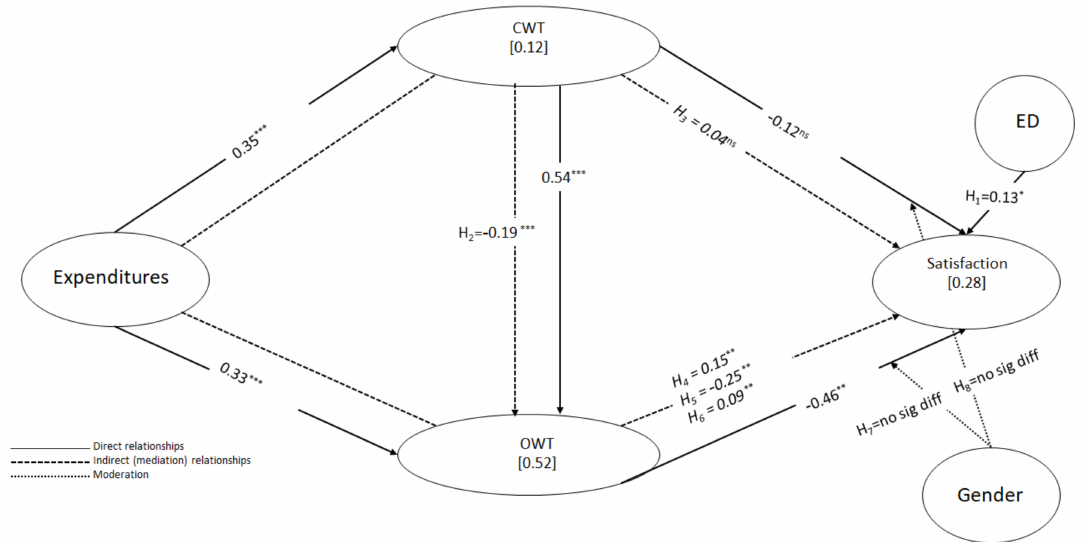
Figure 2. Whole model results. *: p < 0.05; **: p < 0.01; ***: p < 0.001; ns not significant.